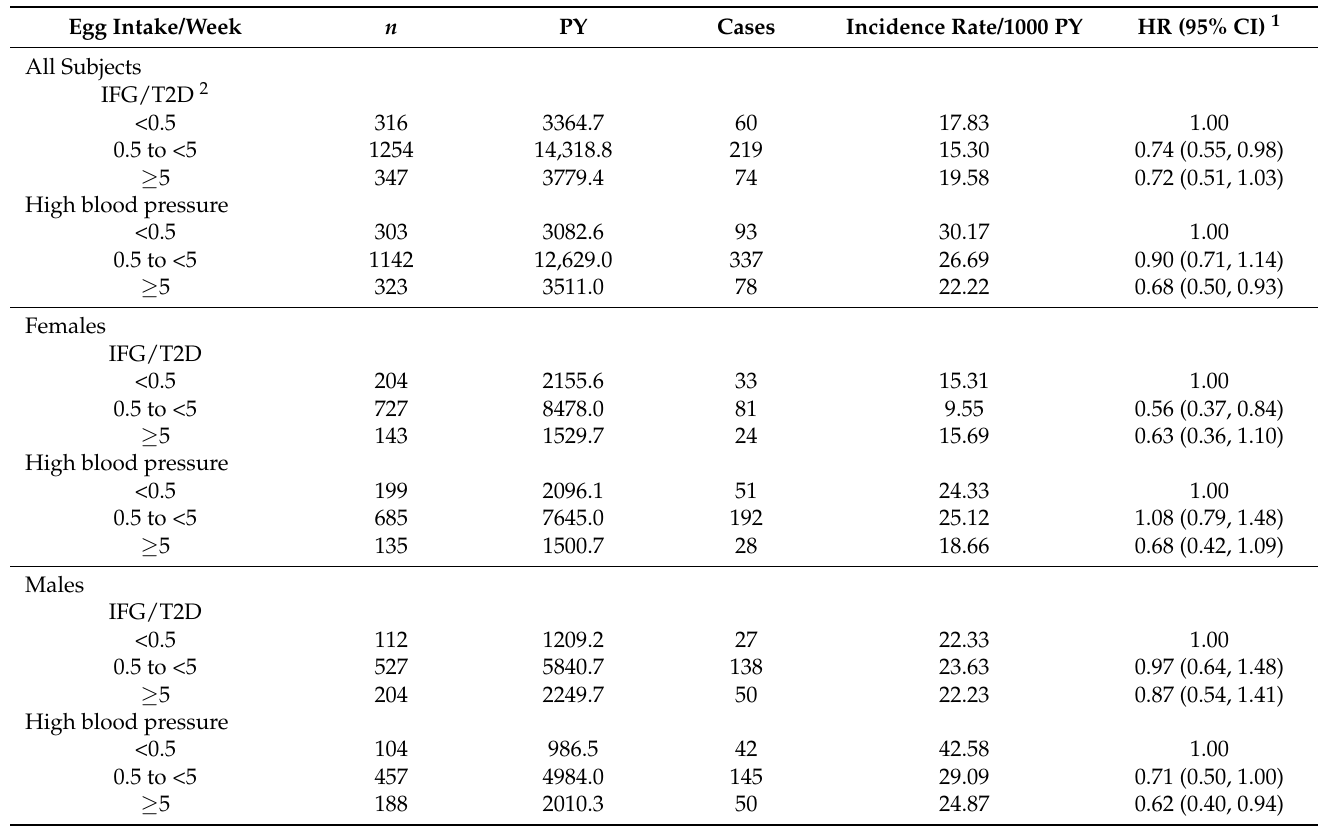
Table 4. Occurrence of impaired fasting glucose or type 2 diabetes and high blood pressure associated with egg intake, overall, and stratifying by sex.